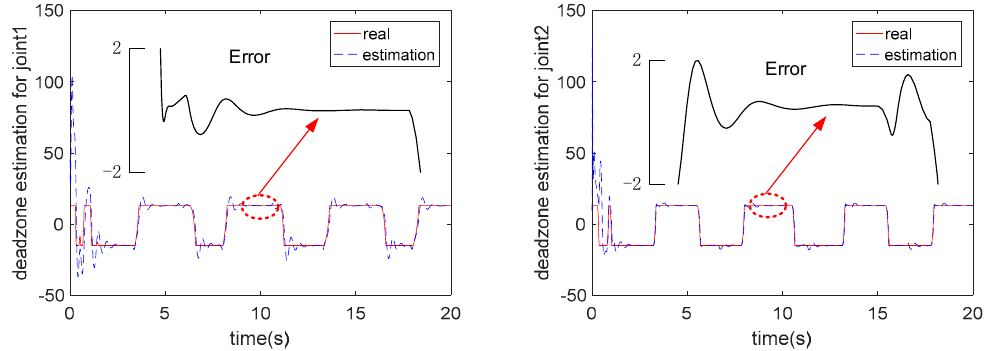
Figure 8. The estimated performance of the dead zone characteristics of joint 1 ( left ) and joint 2 ( right ).